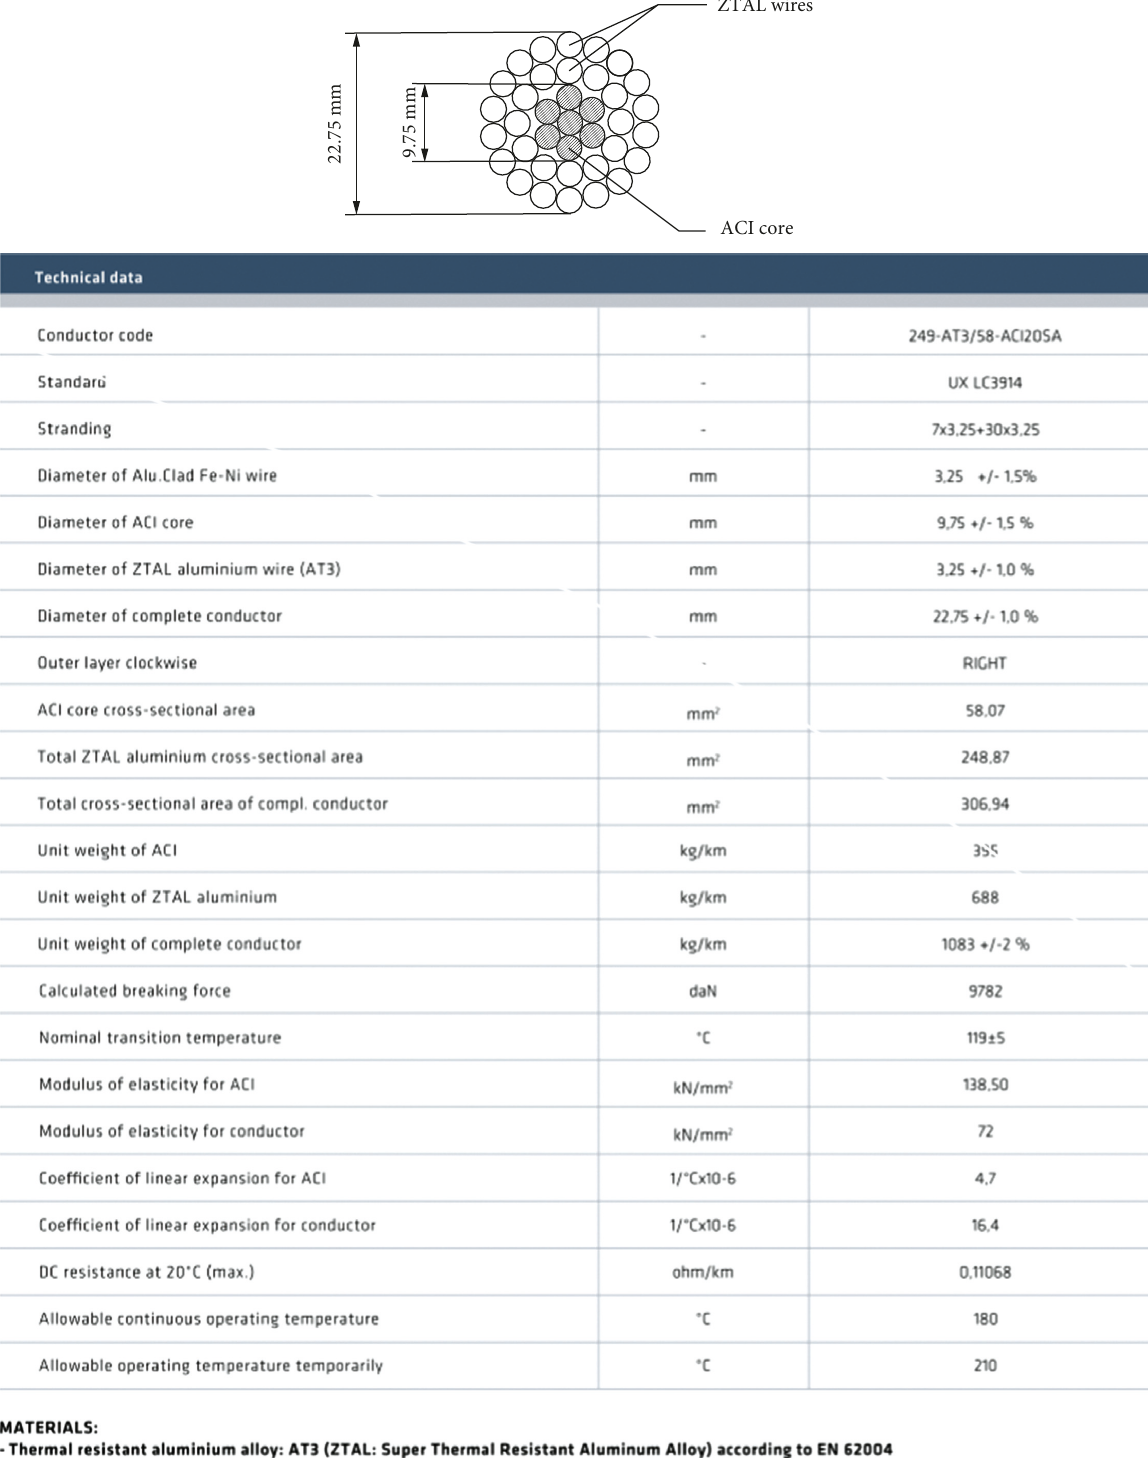
Figure 8: Geometrical data and the main mechanical characteristics of